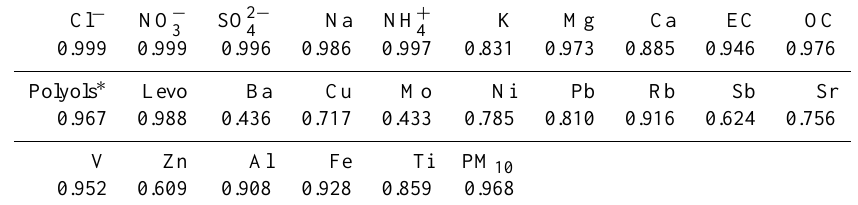
Table 3. Values of the coefficient of correlation ( R 2 ) between measured and modeled concentrations in the base run.